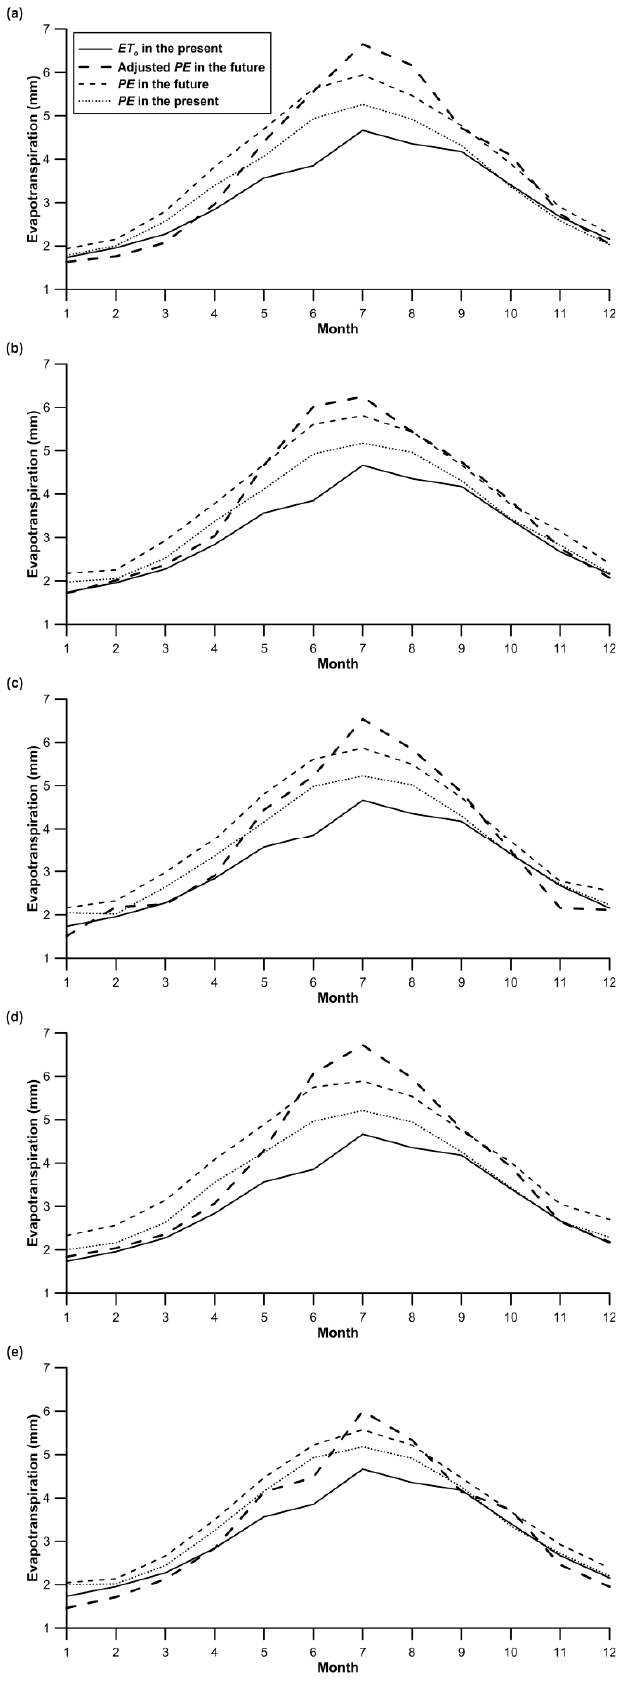
Figure 8. Comparison with before/after bias correction: ( a ) CCCma GCM; ( b ) CNRM GCM; ( c ) CSIRO GCM; ( d ) GFDL GCM; ( e ) LASG